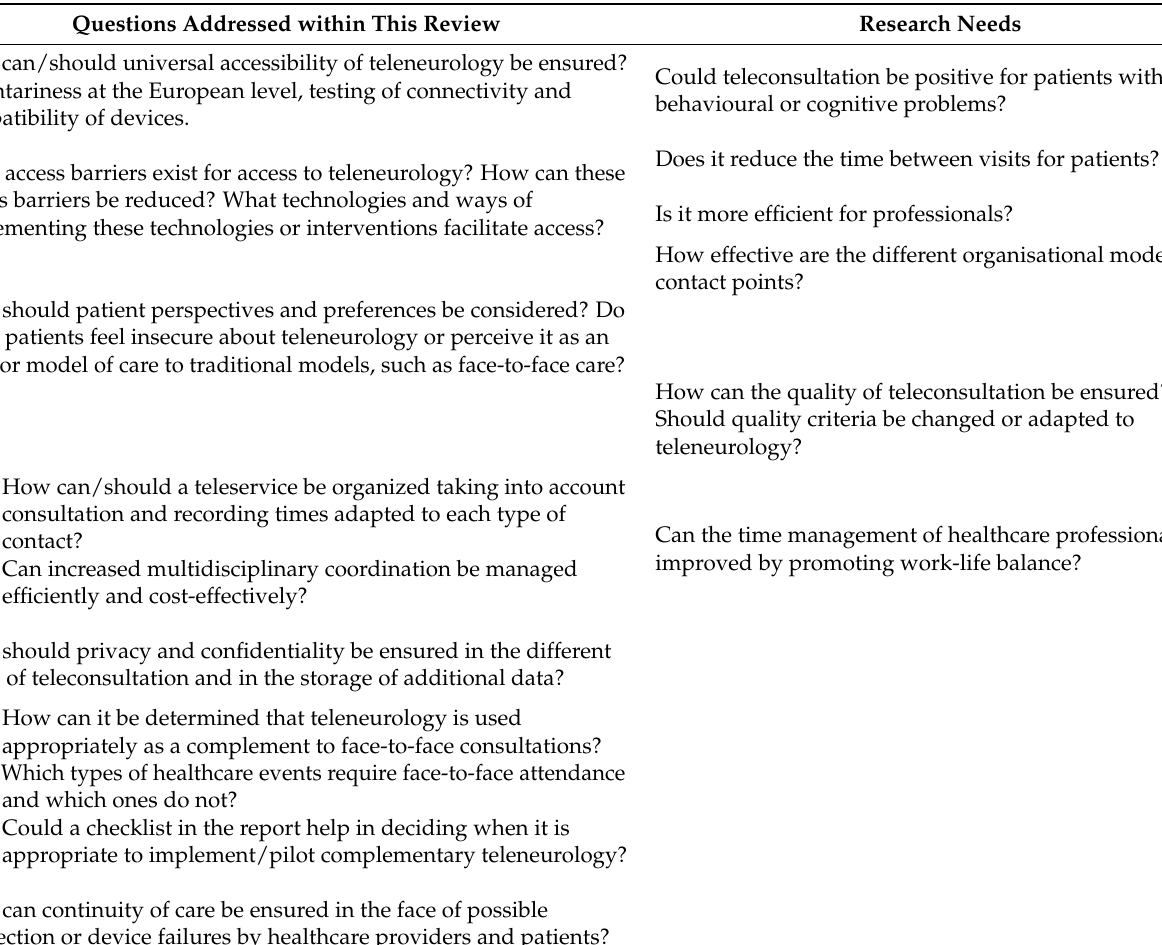
Table 1. Themes emerging from the virtual stakeholder